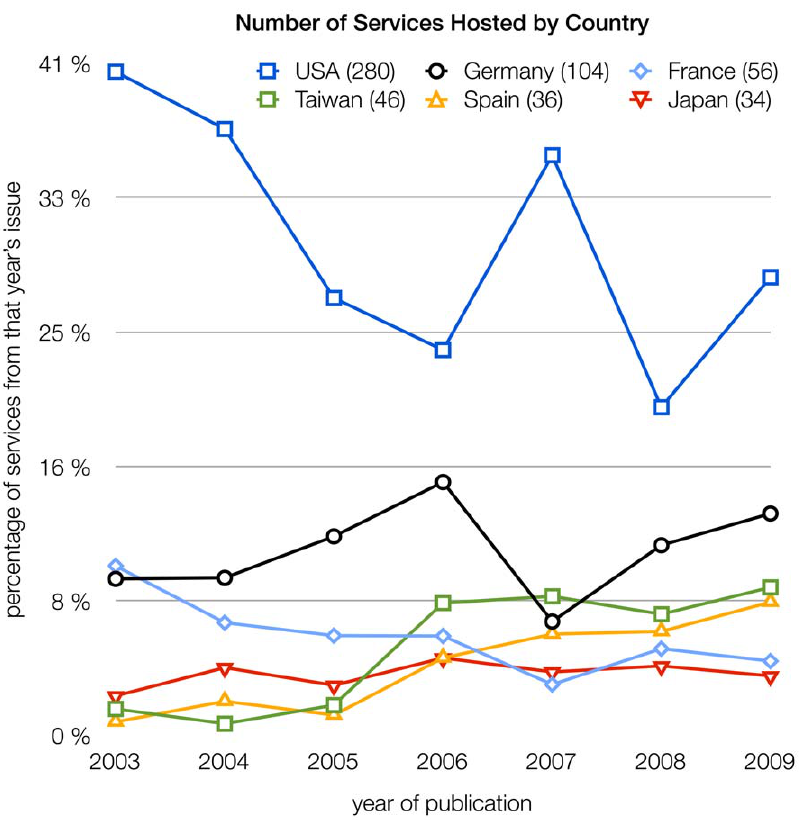
Figure 4. Number of services hosted by country, in percent of services published in that issue. This chart shows six countries with the highest number of hosted services, total numbers are indicated in parenthesis after each country’s name. The ten countries on ranks seven to 16 are Canada (33), India (32), United Kingdom(31), China (27), Italy (27), Israel (26), The Netherlands (23), South Korea (20), Switzerland (20), andSingapore (17).